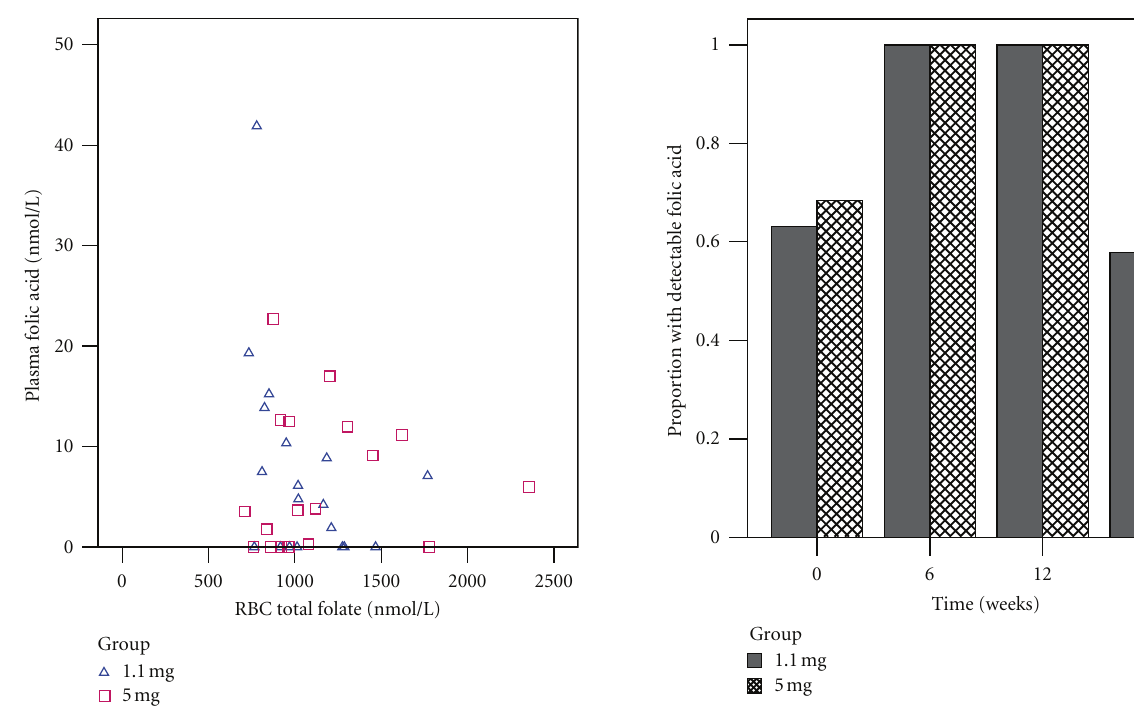
( χ 2 = 10 . 39; df = 3; P = 0 . 019). Posthoc nonparamet-